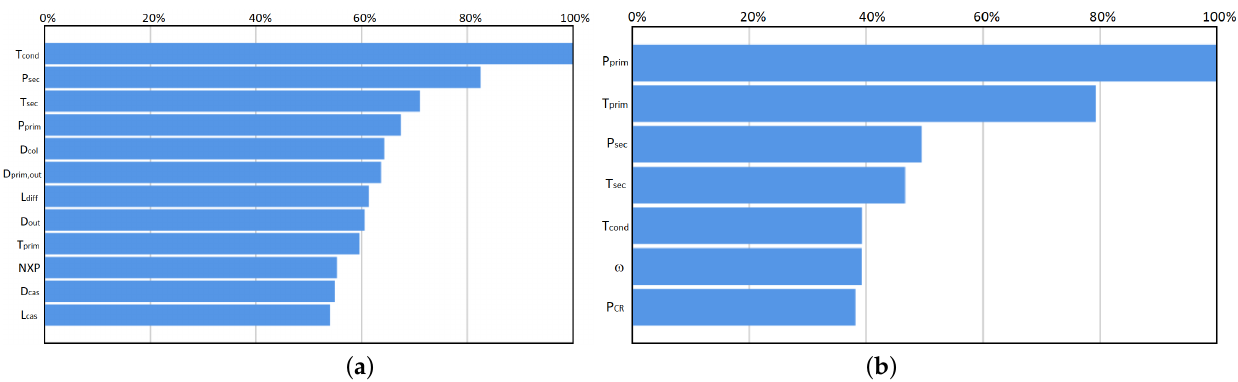
Figure 10. Relative importance of the input parameters on the model predictions for Cases ( a ) 1 and ( b ) 2.